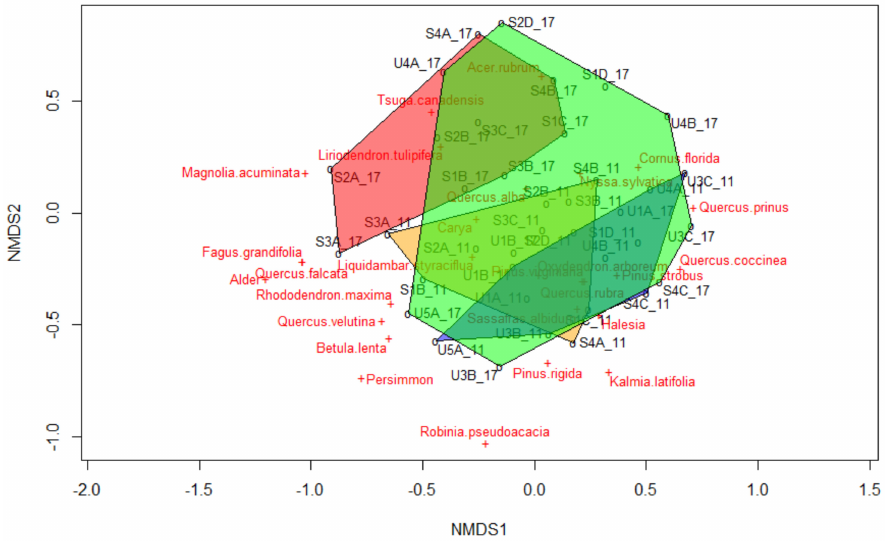
Figure 3. NMDS for trees pre-tornado, pre-salvage ( orange ); pre-tornado, unsalvaged ( blue ); six years post-tornado, post-salvage ( red ); and six years post-tornado, unsalvaged ( green )